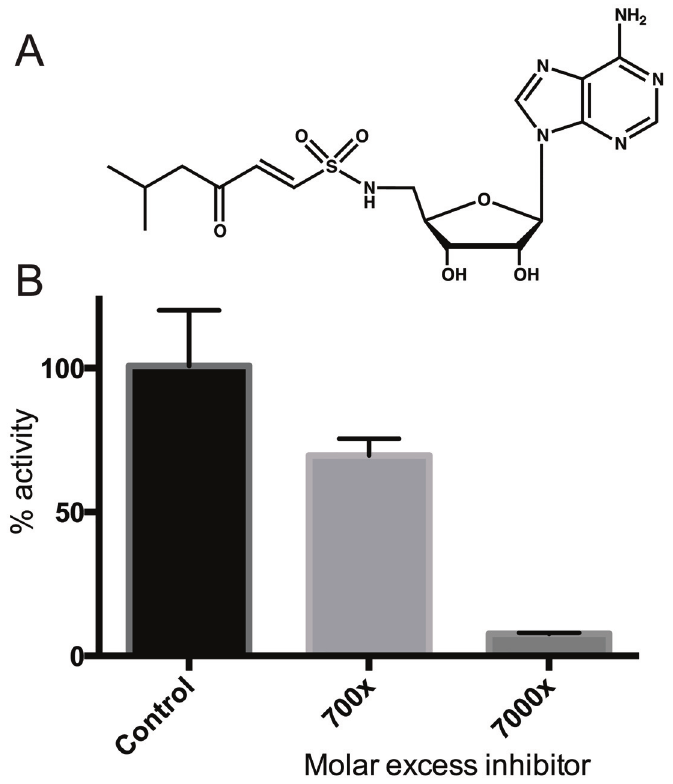
Fig 6. Vinylsulfonamide compounds inhibit α -keto acid adenylation. (A) Structure of the vinylsulfonamide inhibitor for CesA1, α -hydroxyisocaproic acyl-vinylsulfonamide adenylate. The A domain should catalyze the nucleophilic attack of the pantetheine arm thiol on the vinylsulfonamide analogue, but the adenine analogue should not be released in the reaction, trapping the T domain with the A domain. (B) CesA1 is inhibited by the vinylsulfonamide inhibitor. CesA1 was incubated with DMSO or the inhibitor in DMSO. Excess inhibitor and/or DMSO was removed with a desalting column prior to ATP-PPi exchange assay using α